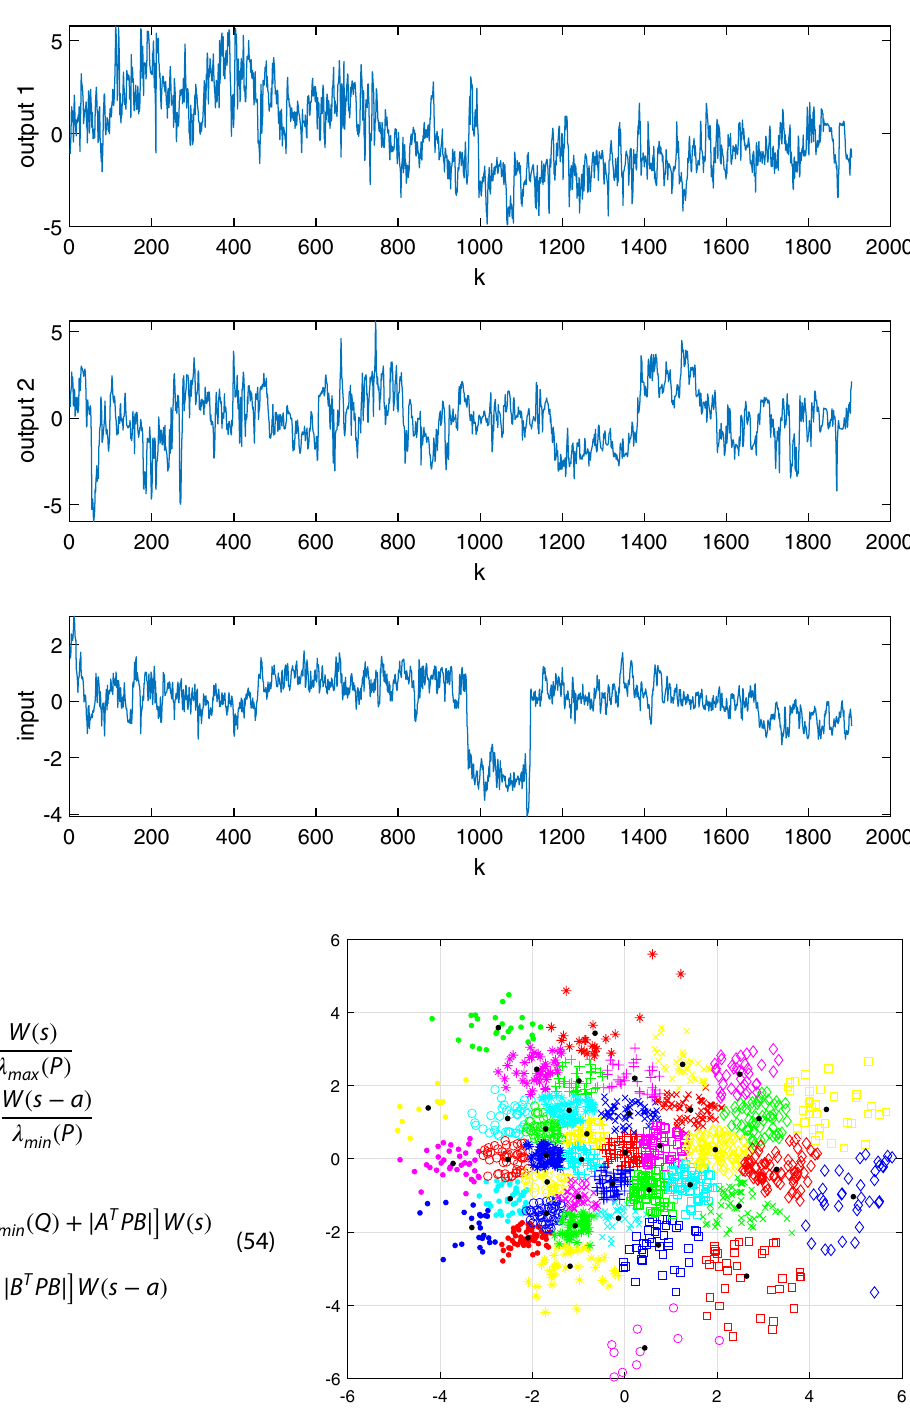
Fig. 4 The results of 2-dimensional